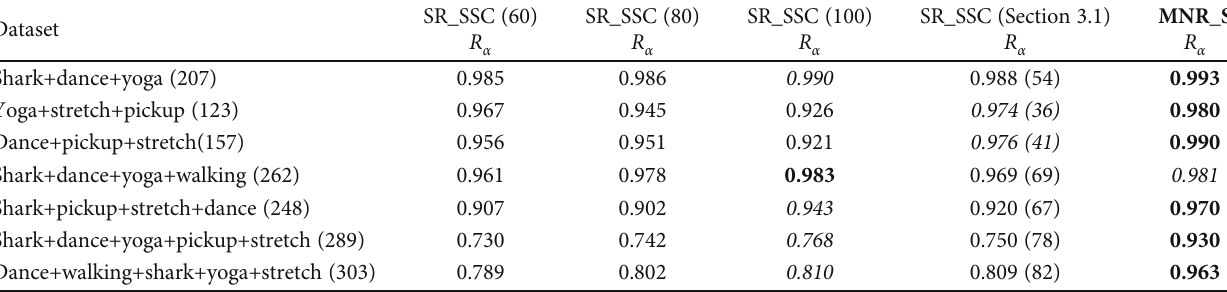
Table 1: Analysis of the anchor trajectories number k estimation.